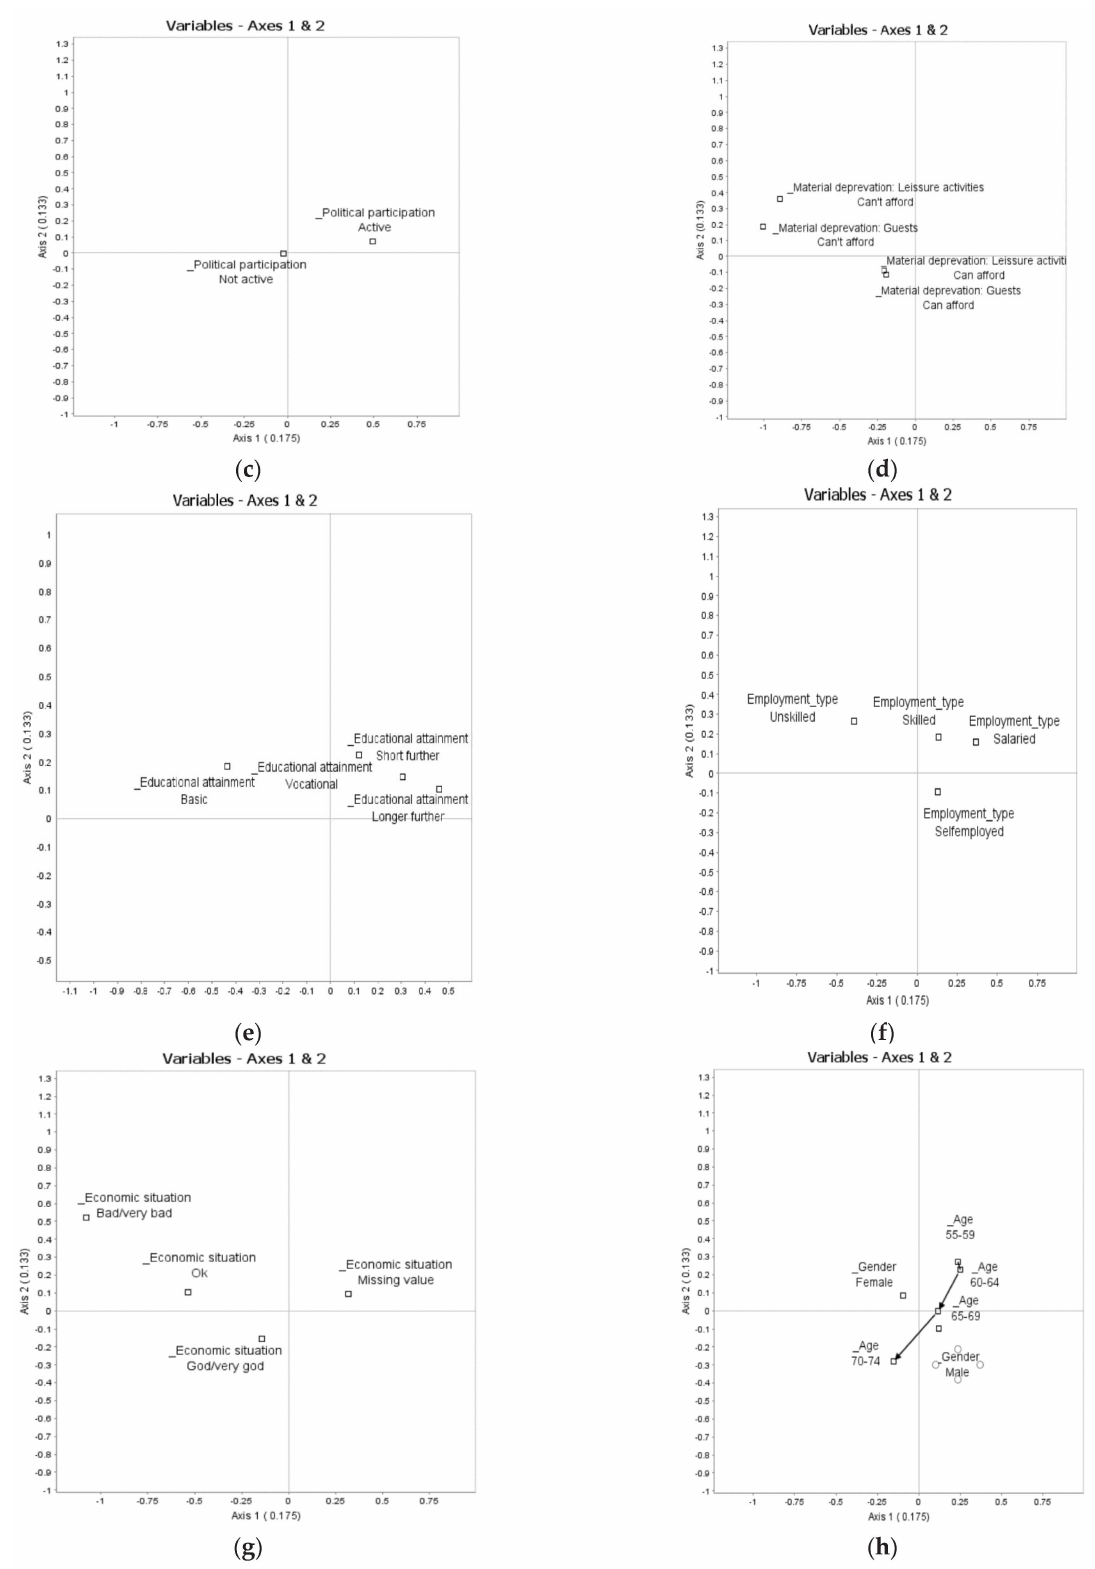
Figure 2. Supplementary variables in the space of active ageing factors. ( a ) Employment by age groups; ( b ) Labour market affiliation; Political participation; ( c ) Political participation; ( d ) Material deprivation; ( e ) Educational attainment; ( f ) Type of employment; ( g ) Financial situation; ( h ) Gender and